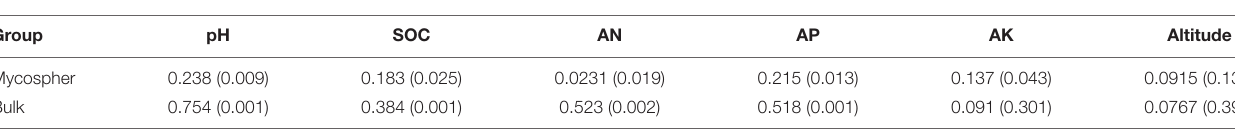
FIGURE 5 | LDA scores showed all the significant genus differences between mycosphere and bulk soil. TABLE 2 | The Mantel test analysis in soil